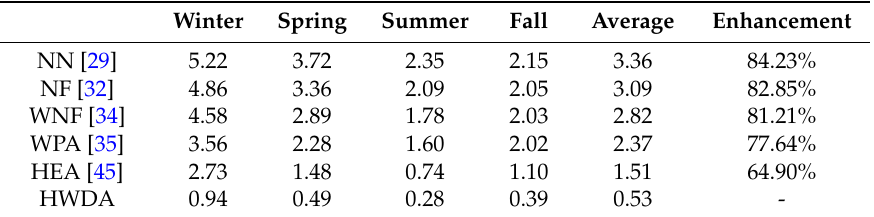
Table 8. NMAE (the normalized root mean square error) comparison for wind power forecasting.